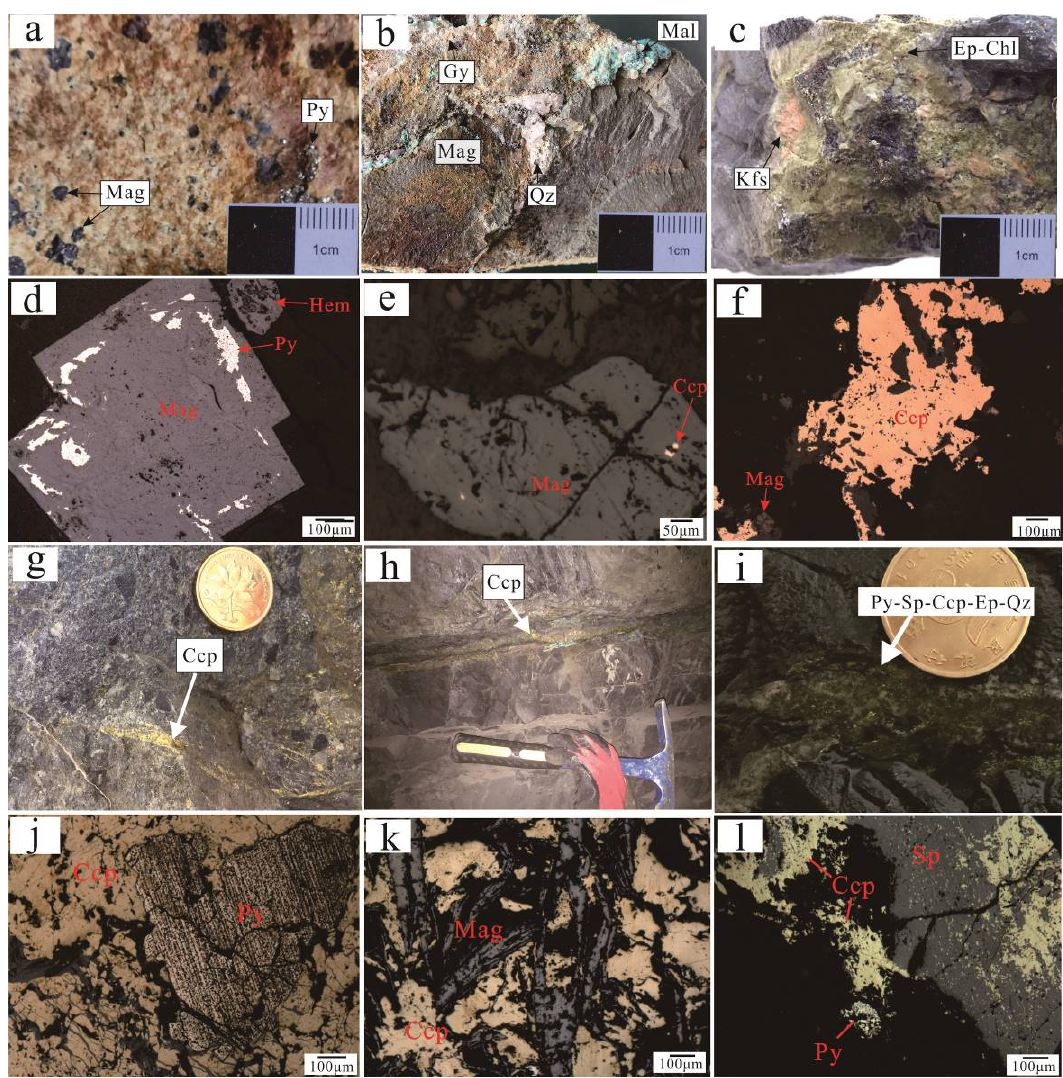
Figure 2. Photographs showing the ore from the Tonggou porphyry and vein mineralization. ( a ) disseminated pyrite and magnetite occurring in Tonggou mineralized granodiorite (TMG); ( b ) stockwork magnetite–malachite–quartz vein from porphyry mineralization; ( c ) potassic and propylitic alteration from porphyry mineralization; ( d ) early pyrite replaced by magnetite showing a metasomatic relict texture from porphyry mineralization; ( e ) disseminated chalcopyrite occurring in magnetite from porphyry mineralization; ( f ) allotriomorphic magnetite and chalcopyrite from porphyry mineralization; ( g ) chalcopyrite veinlets from vein mineralization; ( h ) sulfide ore vein from vein mineralization; ( i ) pyrite–chalcopyrite–sphalerite–epidote–quartz assemblages from vein mineralization; ( j ) euhedral pyrite replaced by allotriomorphic chalcopyrite from vein mineralization; ( k ) allotriomorphic chalcopyrite and leaf-shaped magnetite ; ( l ) allotriomorphic pyrite, chalcopyrite and sphalerite from vein mineralization; Abbreviations: Mag = Magnetite, Py = Pyrite, Ccp = chalcopyrite, Sp = Sphalerite, Gy = Gypsum, Qz = Quartz; Chl = chlorite; Ep = epidote; Kfs = K-feldspar. Vein Cu–Zn mineralization occurs in the Qijiaojing Formation as veinlet, stratiform,